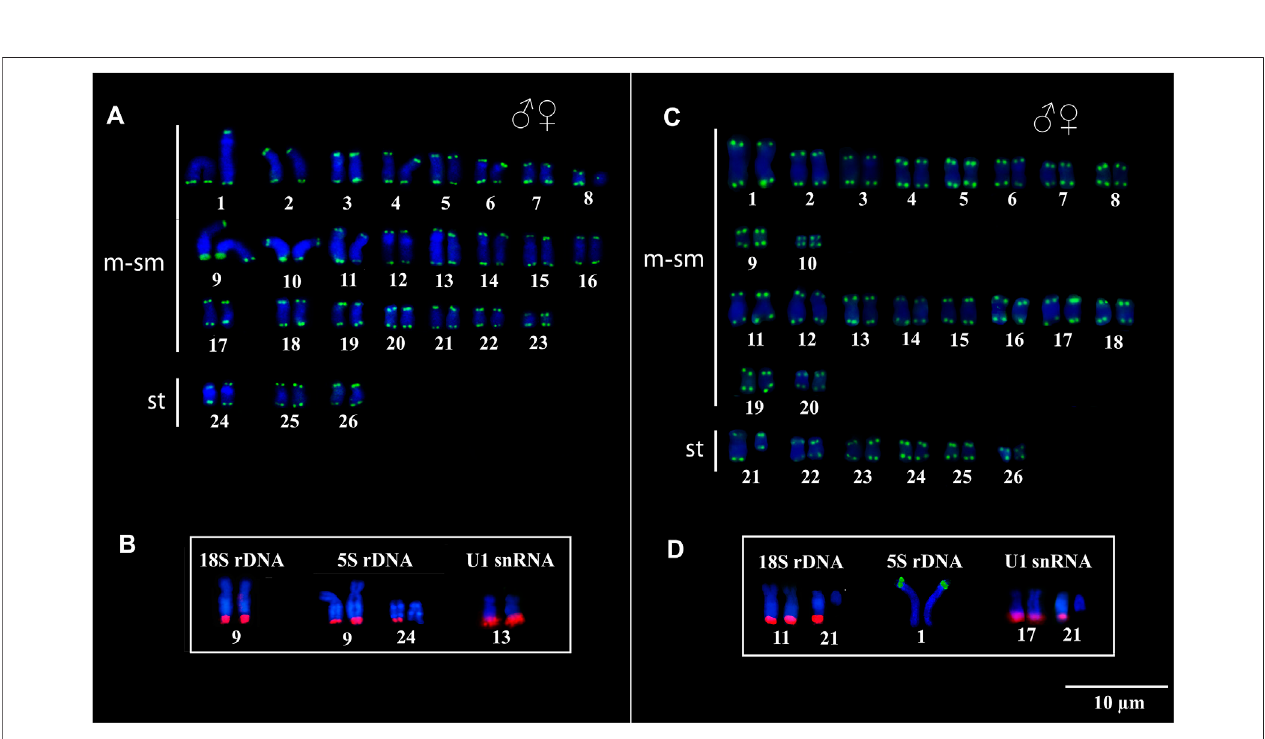
FIGURE 3 | Fluorescent in situ Hybridization indicating the physical location of the Telomeric probes, 18S rDNA, 5S rDNA and U1 snDNA probes in Peckoltia species. In Peckoltia sp. 3 Jarumã: (A) Telomeric sequence (green) and (B) 18S rDNA (red), 5S rDNA (red) and U1 snDNA (red). In Peckoltia sp. 4 Caripetuba: ( C ) Telomeric sequence (green) and (D) 18S rDNA (red), 5S rDNA (green) and U1 snDNA (red).